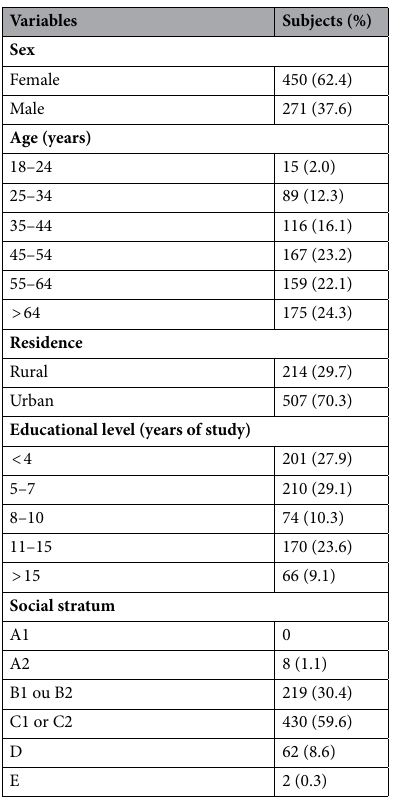
Table 1. Demographic and socioeconomic characteristics of the population (n = 721 subjects). Social categories classified according to the Brazilian Association of Research Companies (ABEP) 21 , being A1 the highest and E the